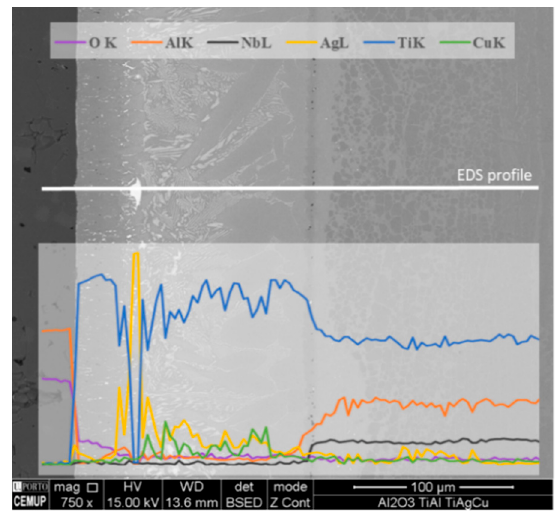
Figure 2. SEM image and energy dispersive X-ray spectroscopy (EDS) line profile on the interface of the brazed Al 2 O 3 / γ -TiAl alloy joint produced at 980 °C for 30 min.